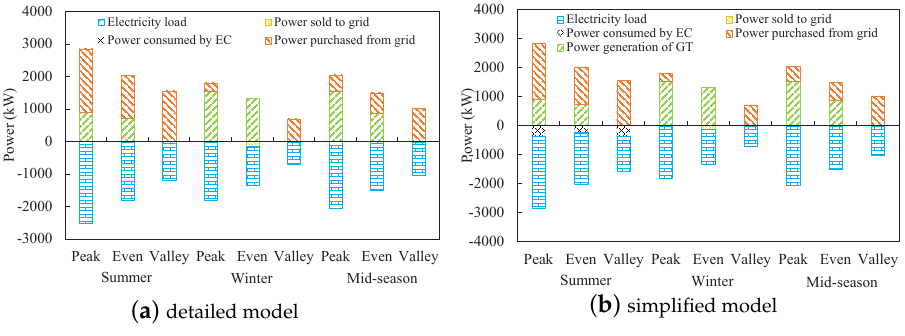
Figure 10. Electricity optimization results as for Case 2.